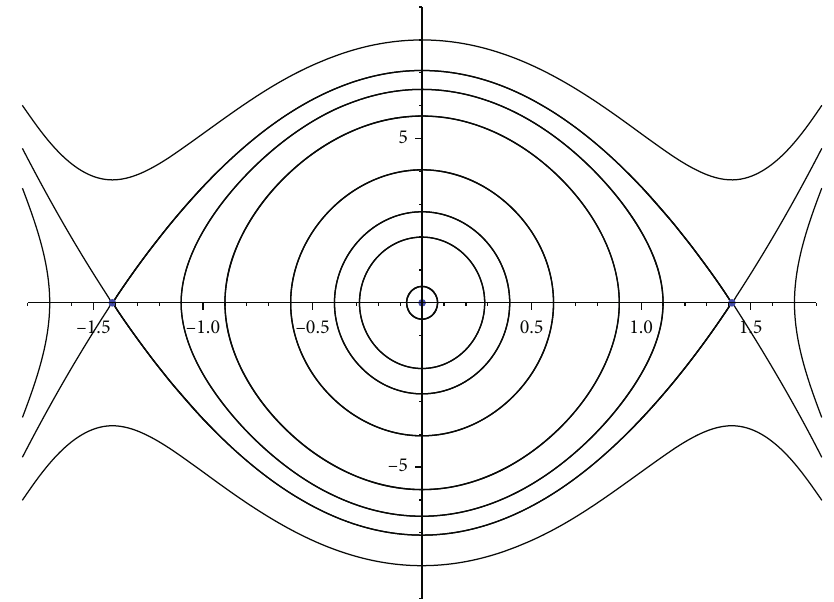
Figure 2: The phase portrait of system (23), a = 50 , b = 25